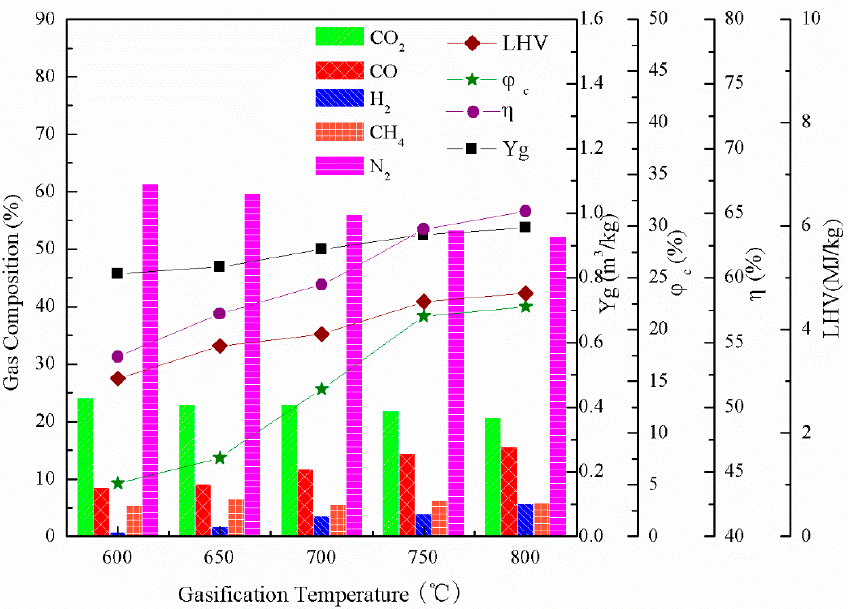
Figure 2. Effect of gasification temperature on combustible gas composition (air flow rate of 0.7 m 3 /h, biomass feed rate of 0.11 kg/h). LHV : low calorific value.